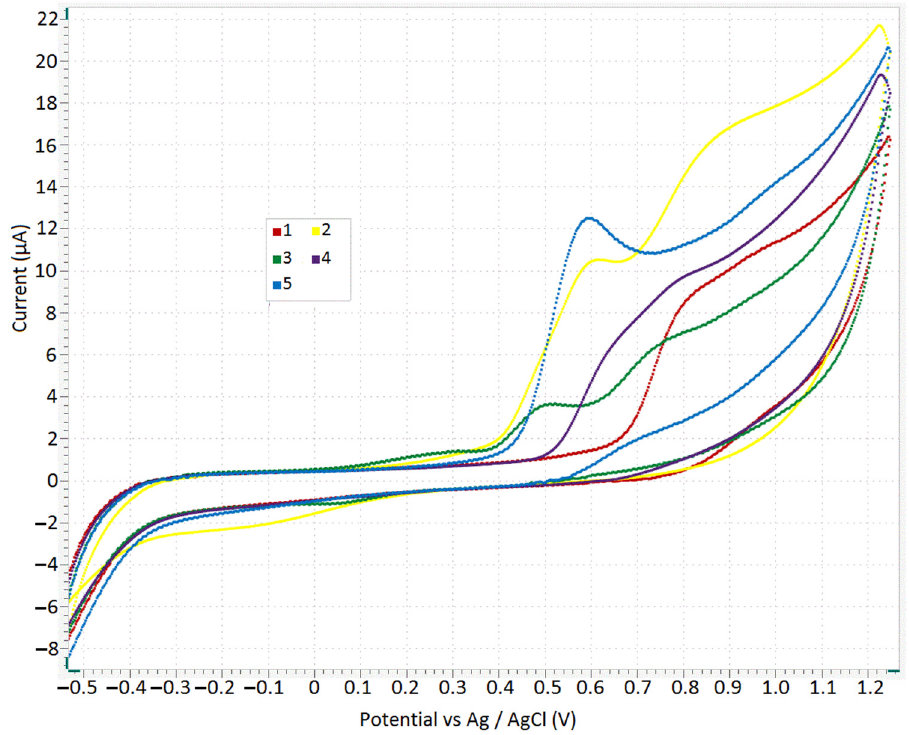
Figure 3. Cyclic voltammograms of Chrysin (1), Genistein (2), Silybin (3), Apigenin (4), 4-methyl-5,7-dihydroxycoumarin (5) recorded on a glassy carbon electrode, reference electrode—silver chloride electrode, C AO = 0.1 mM. Background: phos- phate buffer solution–ethanol 1:1. Scan rate is 0.05 V/s.